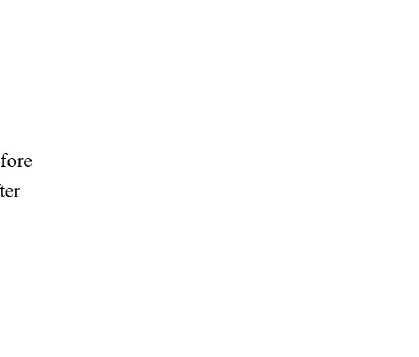
Figure 17. The angular velocity ω 6 of the driver side output-link of CDLS before/after DE optimization.